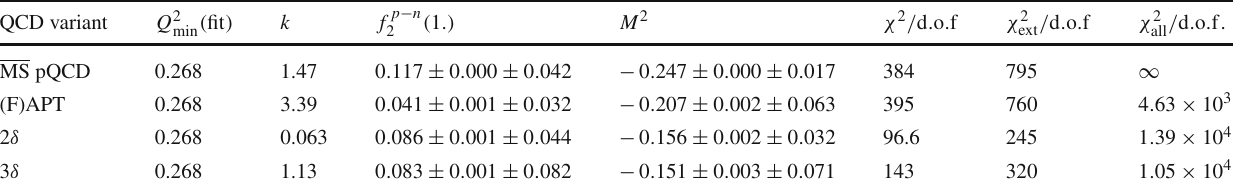
Table 6 As in Table 3, i.e., the OPE form is “massive”, Eq. (16), but now the elastic part of BSR is included in the fit QCD variant